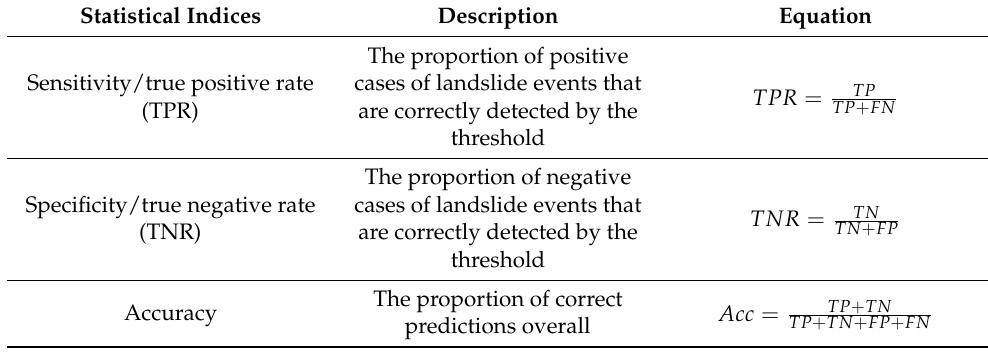
Table 2. Statistical indices used to measure the performance of the thresholds.